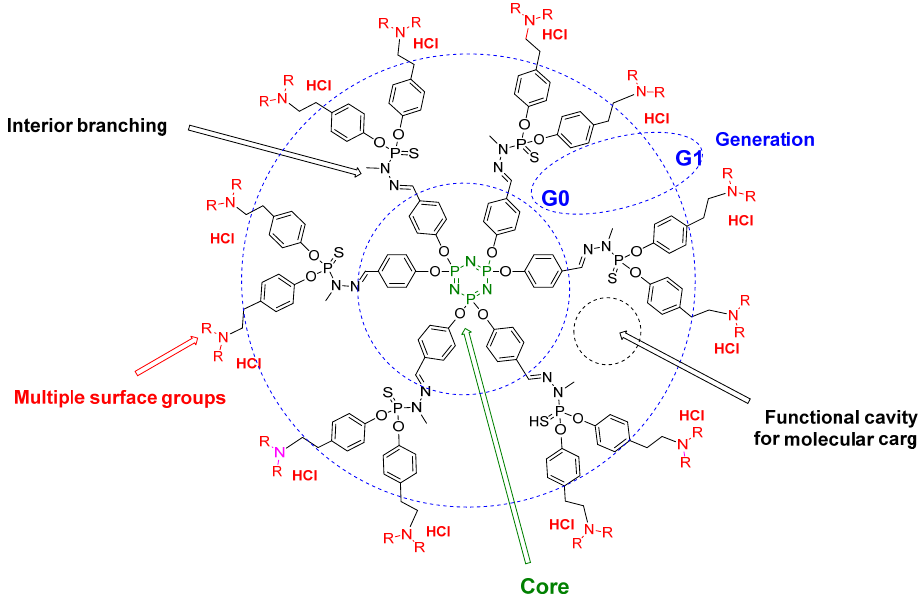
Figure 1. Two-dimensional chemical structures of phosphorus dendrimers: generations 0 and 1.